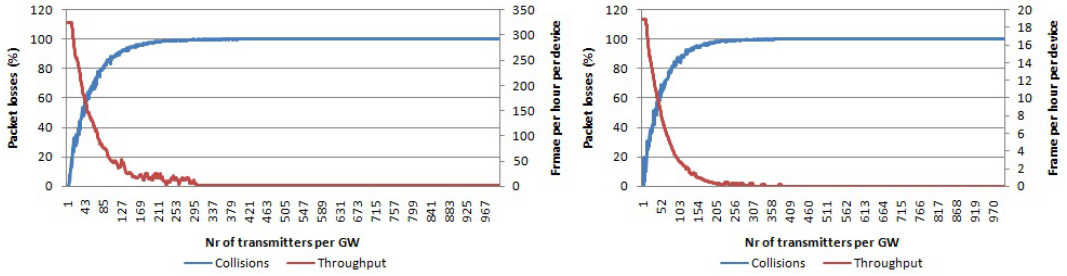
Figure 11. Percentage of packets lost due to collisions per number of transmitters per gateway using pure Aloha access. Average throughput per device. Single channel, single SF and payload size 20 bytes. ( left ) Using SF 7; ( right ) using SF 12.